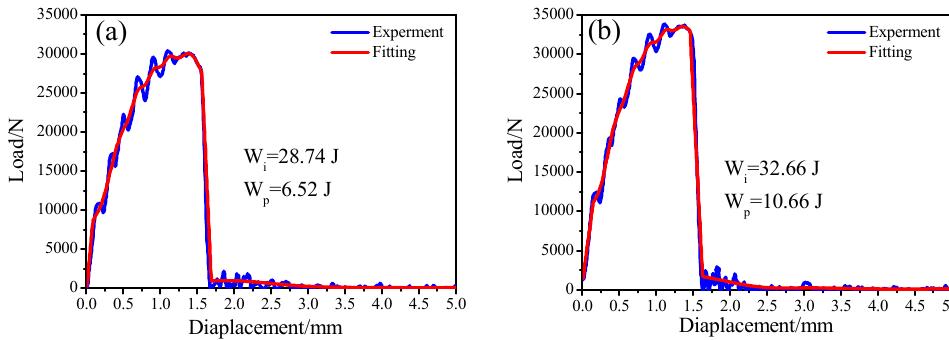
Figure 11. The displacement ‐ load curves of ( a ) 540 °C; ( b ) 630 °C.